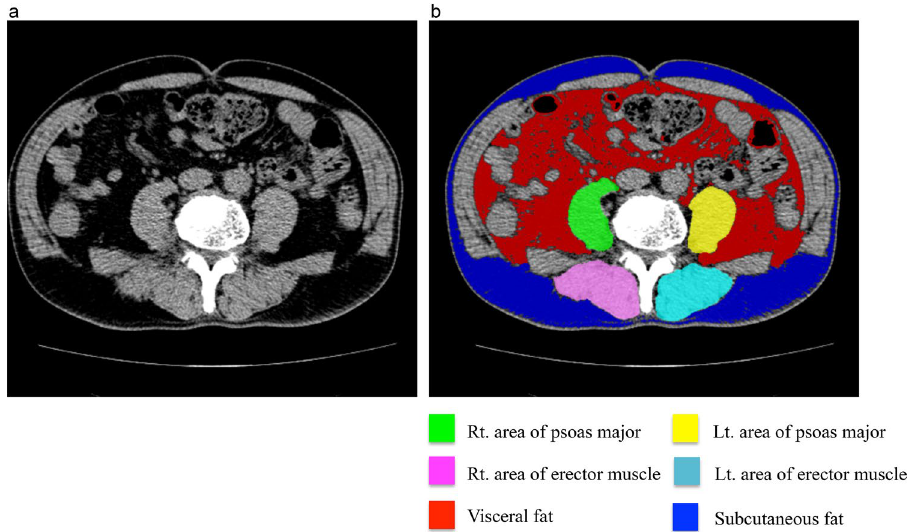
Figure 3. Representative view with musclePointer software. ( a ) An original image at the level of the umbilicus as observed using computed tomography. ( b ) Software calculated the area of each muscle